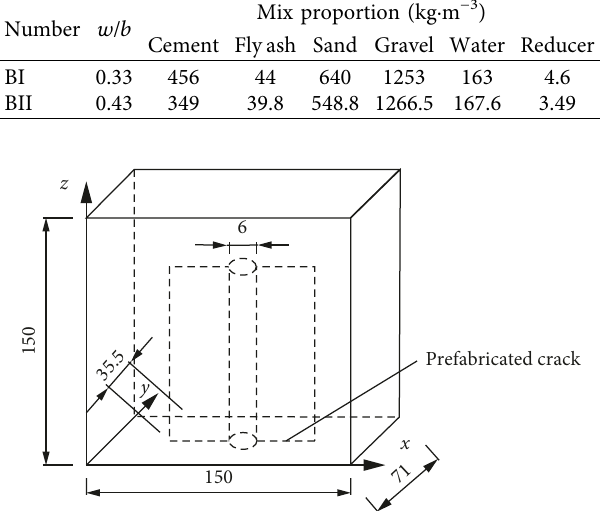
Figure 1: Concrete block schematic (unit: